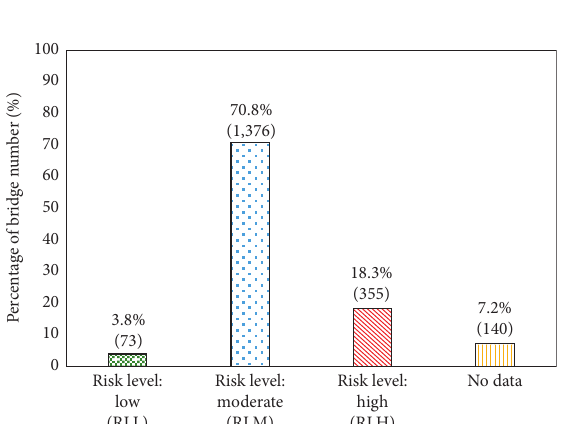
Figure 6: Results of vulnerability.